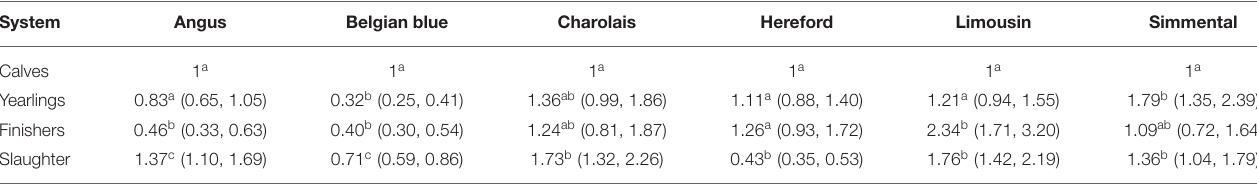
TABLE 4 | Odds ratio (95% confidence interval in parentheses) of an Angus, Belgian Blue, Charolais, Hereford, Limousin, or Simmental bull being used for each of the different markets when the dataset was limited to just beef sires. System Angus Belgian blue Charolais Hereford